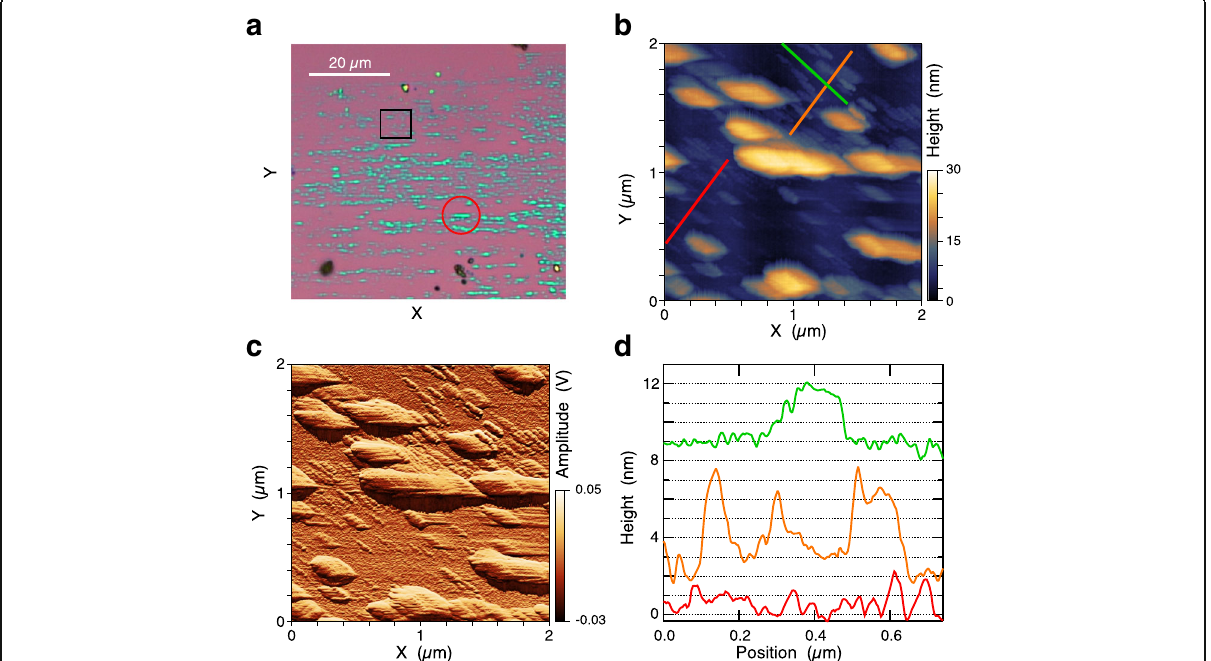
Fig. 3 a Optical micrograph of a second exfoliated Te sample. The red circle indicates the region used for Raman spectroscopy. b AFM height and ( c ) tapping mode amplitude images of the region indicated by the black square in ( a ). d Height profiles along the red , orange , and green lines in ( b ), perpendicular to the c- axis direction for red and orange , parallel for green . The orange and green profiles are offset vertically for